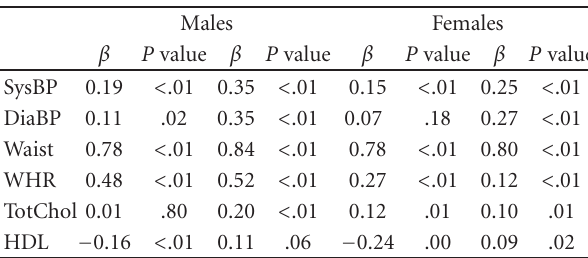
Table 4: Association between BMI and other clinical features. Males